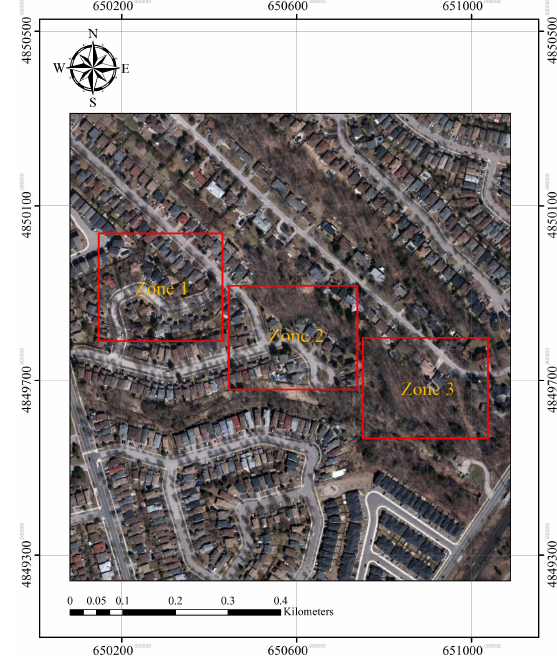
Figure. 2 The three study zones overlaid on the true colour composite of worldview image